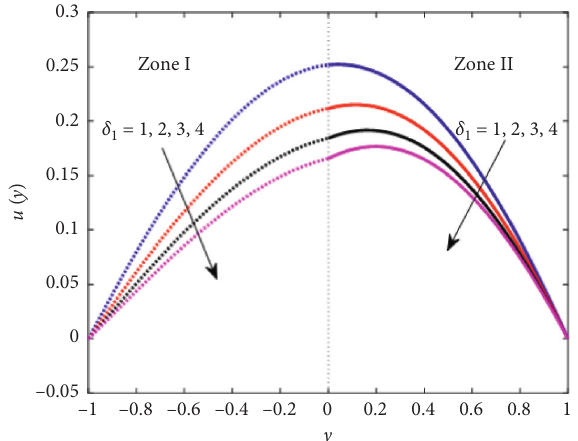
Figure 2: Velocity profiles for various δ